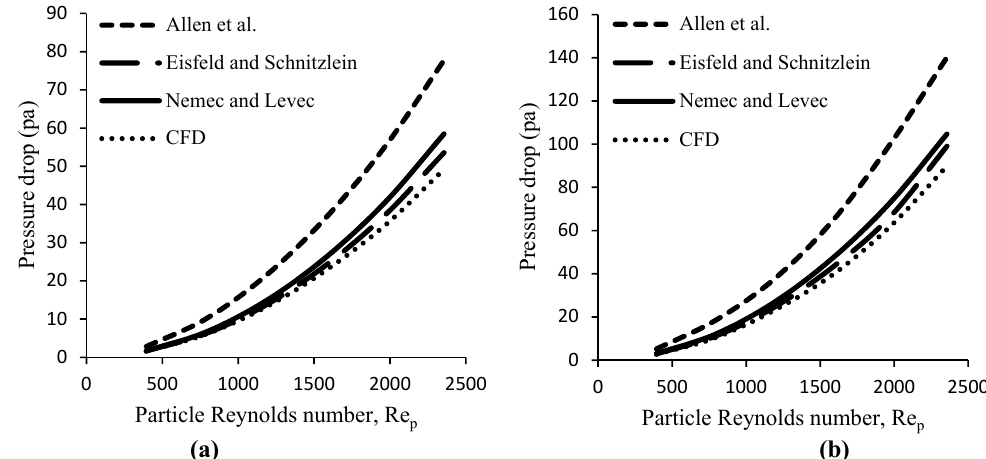
Fig. 8. Comparison of CFD pressure drop with empirical correlations for the packed bed with cylindrical particles in turbulent flow: a) N=6.26 and b) N=9.39.